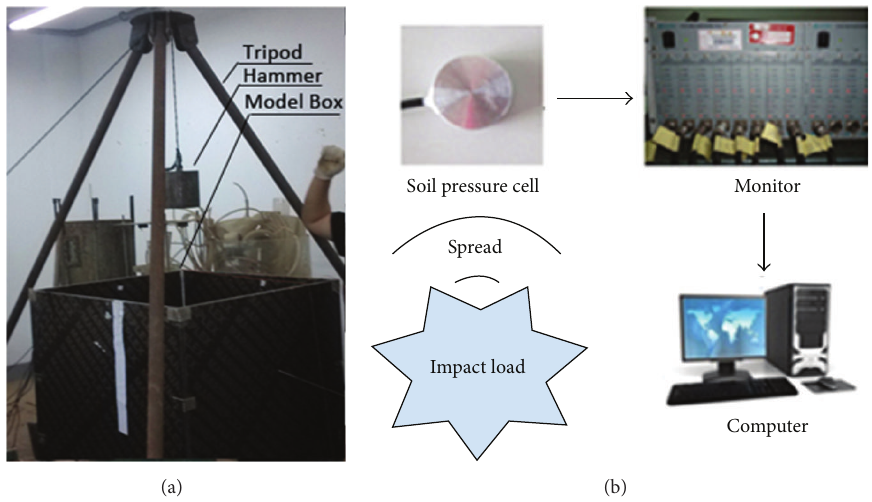
Figure 1: Experimental apparatus: (a) setup; (b) instrumentation.